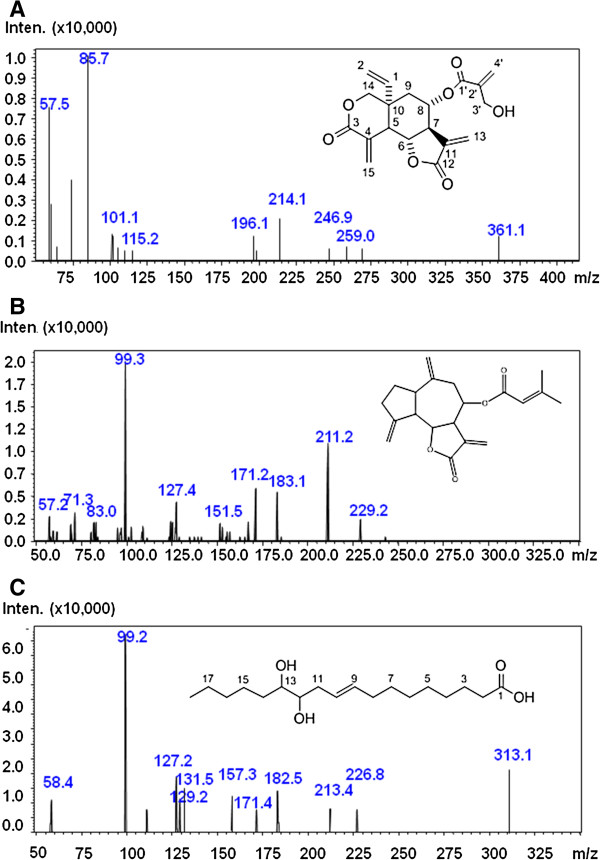
MS/MS spectra and the corresponding chemical structure of the identified compounds. (A) vernodaline, (B) vernuflorid, (C) 12,13- dihydroxyoleic acid.